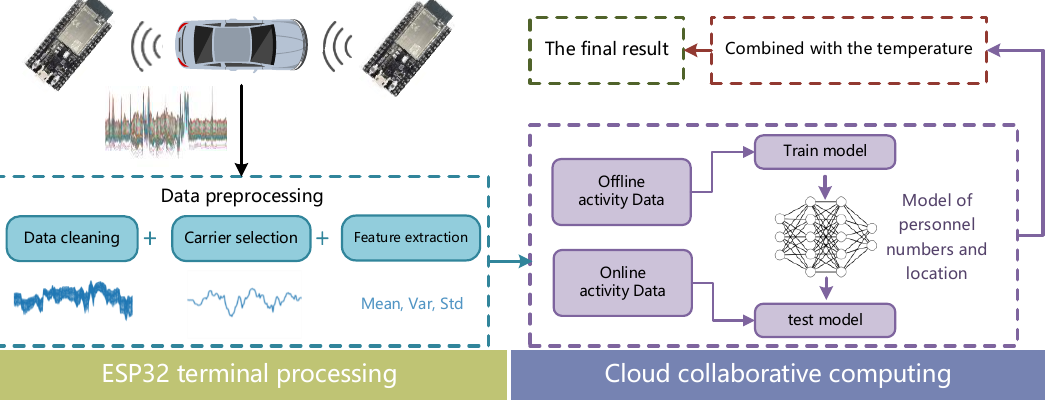
Figure 7. Edge-side computing + cloud co-computing.